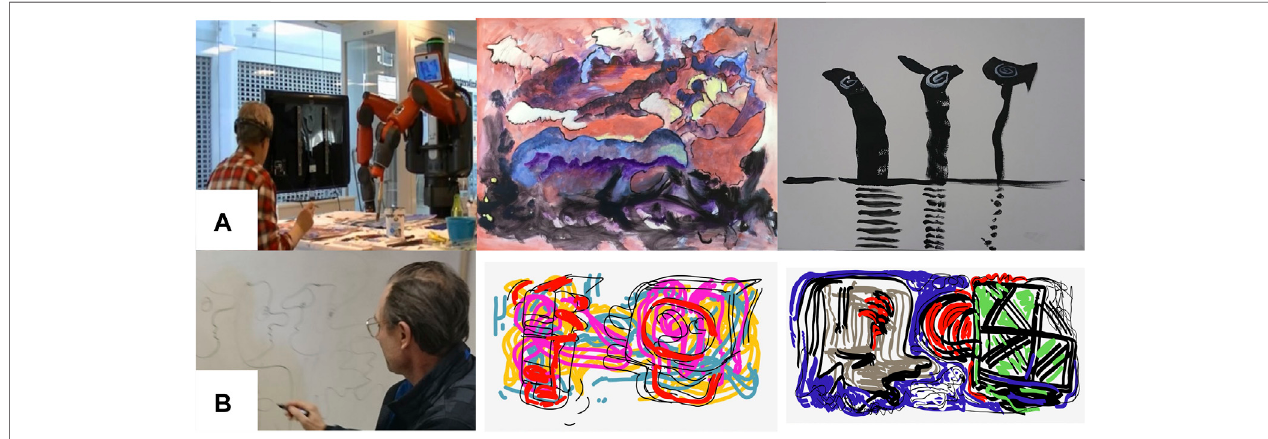
FIGURE7| Twoprofessionalartistsassistedinourexplorationbyprovidingadviceandcreatingexamplesofemotionalart,e.g.: (A) someartbyDanKoonshowing use of color and form, (B) some art by Peter Wahlbeck showing positive and negative emotions.